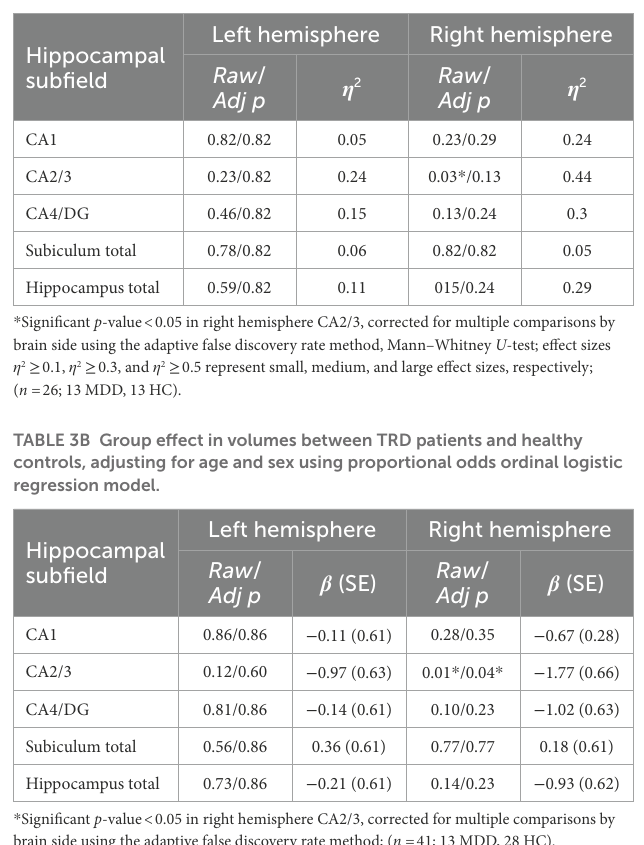
TABLE 3A Group differences in volumes between TRD patients and healthy controls.